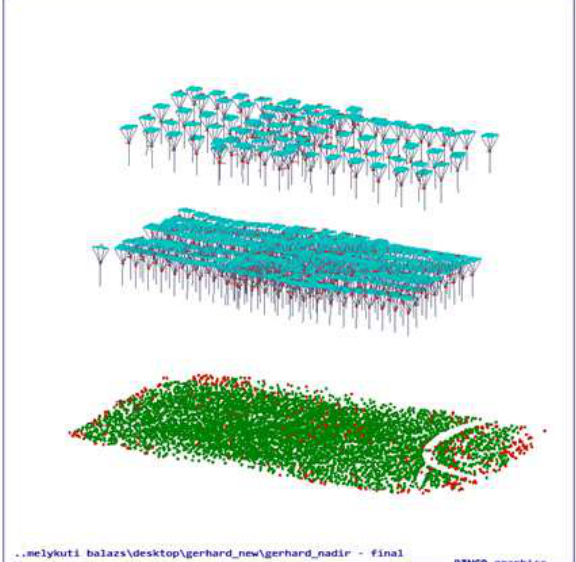
Figure 10: adjustment of the Tie- points during the bundle